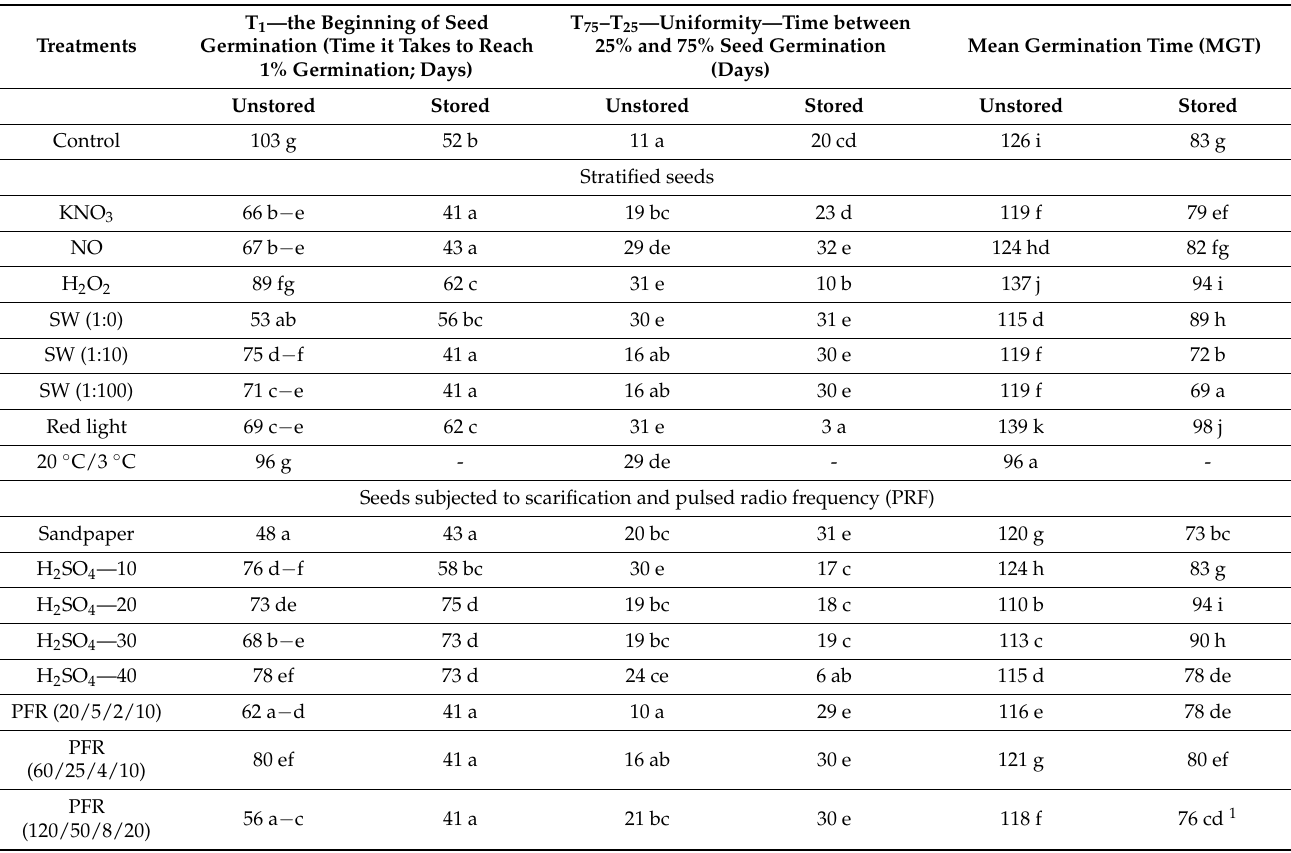
Table 2. T 1 , T 75 –T 25 and MGT of unstored and stored Saskatoon seeds stratified in the presence of distilled water (control), KNO 3 , NO, H 2 O 2 , smoke-water or warm–cool stratified (20/3 ◦ C) in distilled water or subjected to red light treatment or scarified (sandpaper, sulfuric acid for 10, 20, 30 and 40 min) or subjected to pulsed radio frequency (PRF, 20/5/2/10, 60/25/4/10,